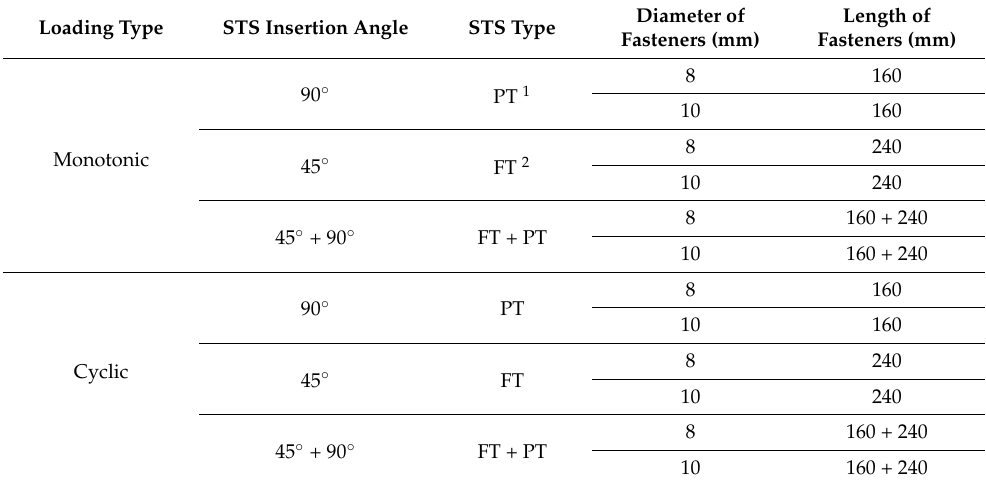
Table 2. Test Table 2. Test matrix.